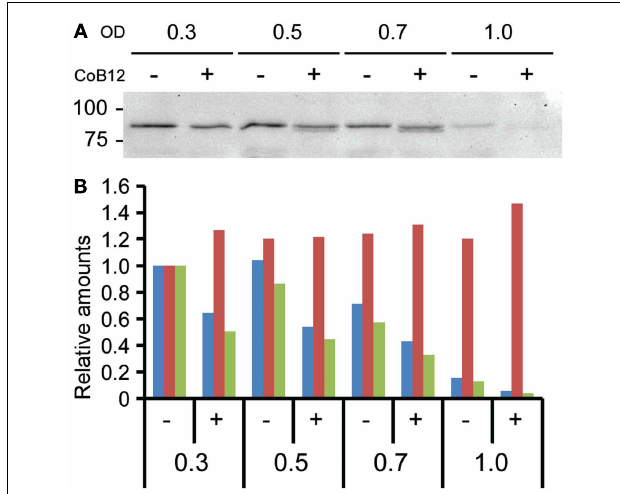
FIGURE 3 | BtuB regulation by the cbl-1 riboswitch. (A) Western blot of lysates of P. gingivalis expressing BtuB::FLAGx3 protein, probed with anti-FLAG antibody. OD: optical density at 600nm; CoB12: culture with 100 µ M Coenzyme B12. Molecular mass markers are shown in kDa. (B) Ratio (green bars) of BtuB::FLAGx3 protein levels to Mfa loading control using Image lab software (Bio-Rad) from western blot results with anti-FLAG (blue bars) and anti-Mfa (red bars) antibodies. For normalization, protein levels at OD = 0.3 were taken as 1.0.